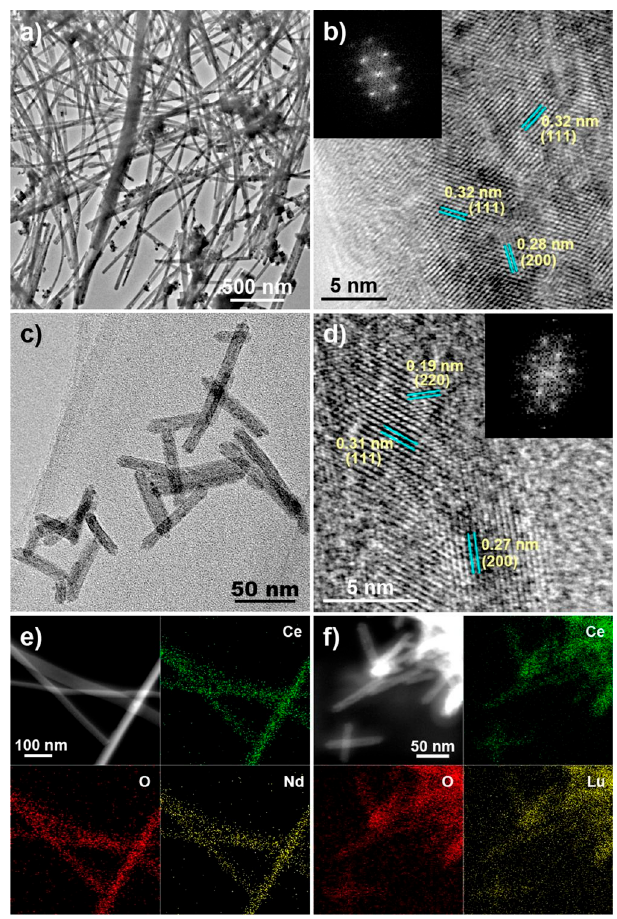
Figure 14. TEM ( a , c ), HRTEM ( b , d ) and HAADF-STEM EDS elemental mapping ( e , f ) images of CeO 2 :Nd ( a , b , e ) and CeO 2 :Lu nanocrystals ( c , d , f ). Insets in Panels ( b ) and ( d ) are the fast Fourier transition analyses, indicating that (110) surfaces are exposed for both samples. In Panels e and f , the up-left images are the HAADF-STEM images. The upper right and bottom left and right ones in Panels ( e , f ) are the EDS elemental mapping images representing Ce, O and the dopant (Nd for panel ( e ) and Lu for panel ( f )) [113]. Reprinted with permission from Ke, J.; Xiao, J.-W.; Zhu, W.; Liu, H.; Si, R.; Zhang, Y.-W.; Yan, C.-H. Dopant-Induced Modification of Active Site Structure and Surface Bonding Mode for High-Performance Nanocatalysts: CO Oxidation on Capping-free (110)-oriented CeO 2 :Ln (Ln = La–Lu) Nanowires. J. Am. Chem. Soc. 2013 , 135 , 15191–15200. Copyright (2013) American Chemical